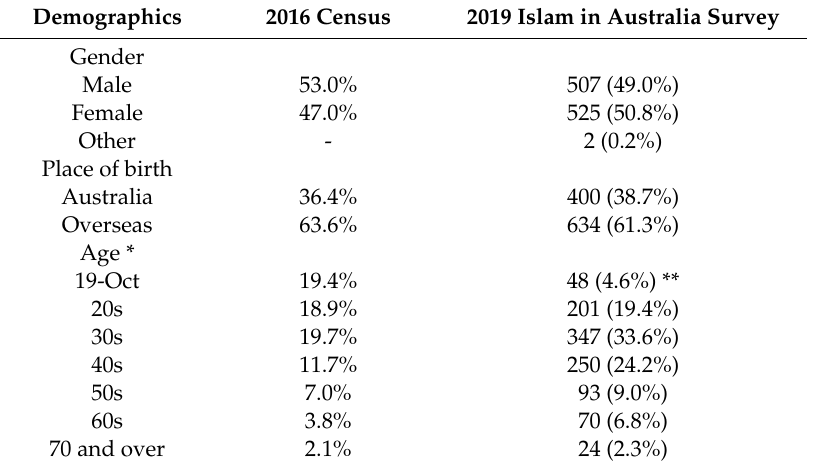
Table 1. Demographics: Census data and survey